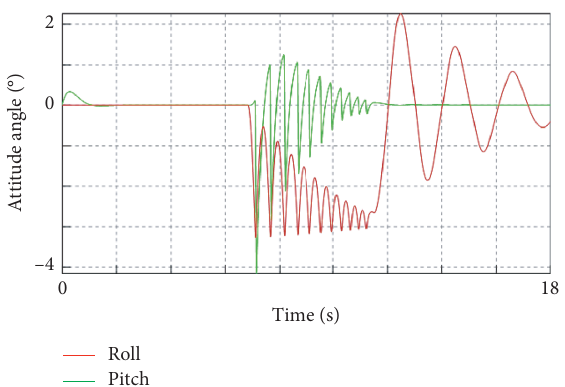
Figure 8: Change of the attitude angle of the single-bogie vehicle after the introduction of the supporting wheels.